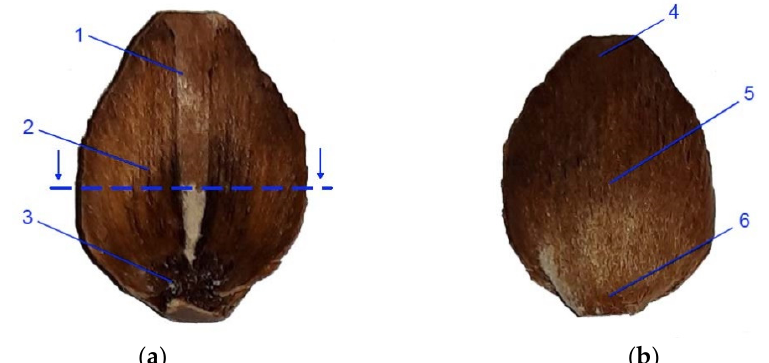
Figure 2. View of larch scale from the middle part of the cone: ( a )—inner side (with the cross-section area marked): 1—wing area margin in the distal part of the scale, 2—wing area in the middle part of the scale, and 3 – seed depression in the proximal part of the scale; ( b )—outer side: 4—distal part, 5—middle part, and 6—proximal part of the scale.